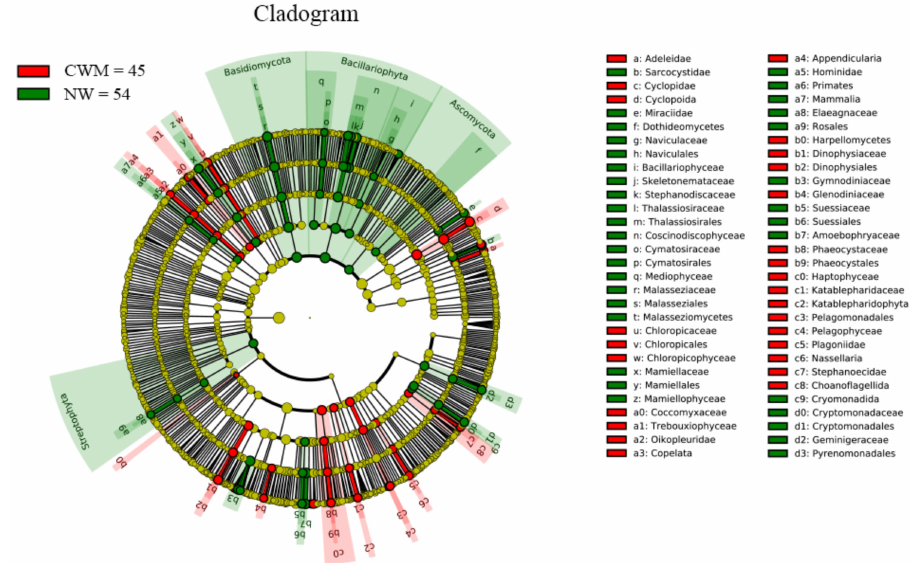
Figure 7. Cladogram plotted from LEfSe comparison analysis indicates the taxonomic representation of statistically and biologically consistent differences in identified biomarkers among different waters (CWM: Cold Water Mass; NW: nearshore